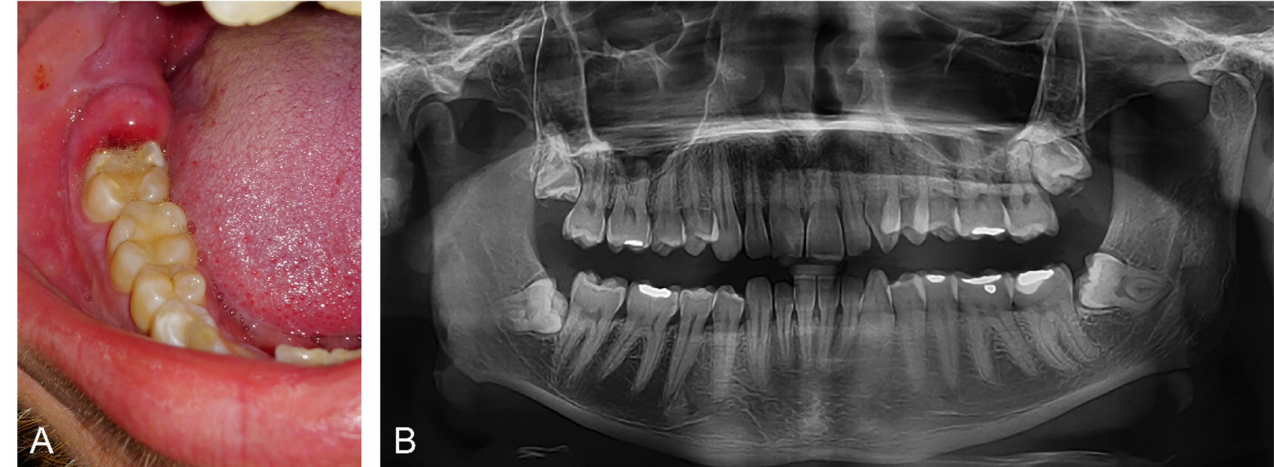
Figure 4. Clinical manifestation of pericoronitis and panoramic radiograph. Image ( A ) demonstrates inflamed soft tissues covering incompletely erupted right lower third molar. Image ( B ) displays a preoperative panoramic radiograph of the same patient demonstrating incompletely erupted third